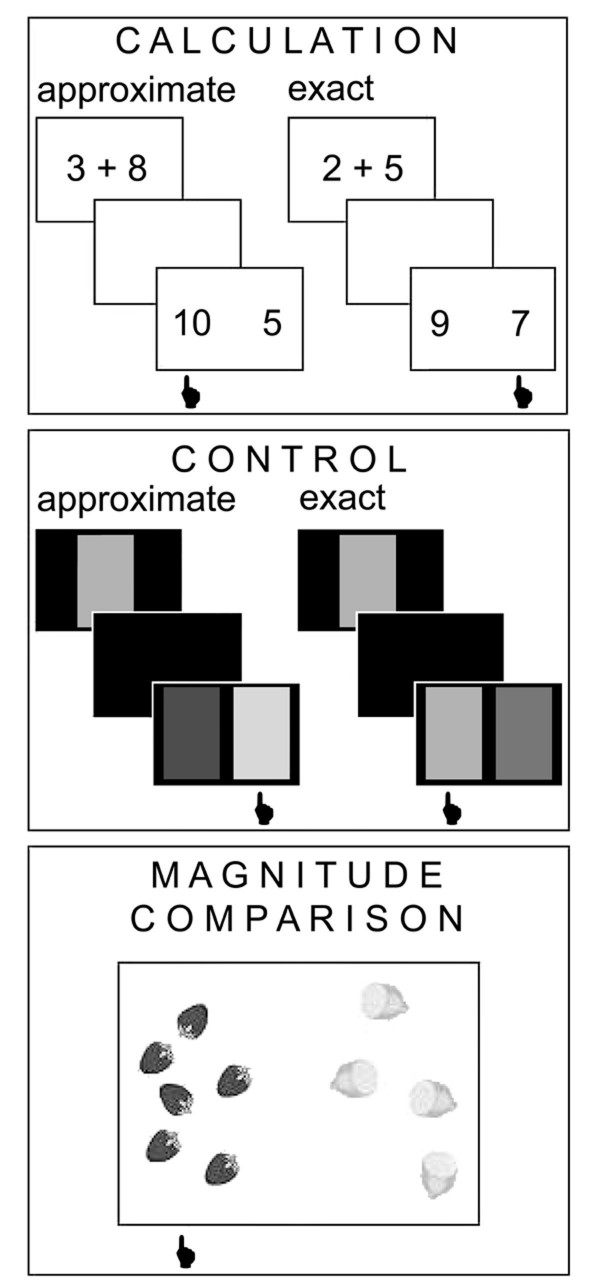
Paradigm. The paradigm used during fMRI examination consisted of approximate and exact calculation, approximate and exact control conditions as well as magnitude comparison. Each condition was presented in three blocks of 80 s.